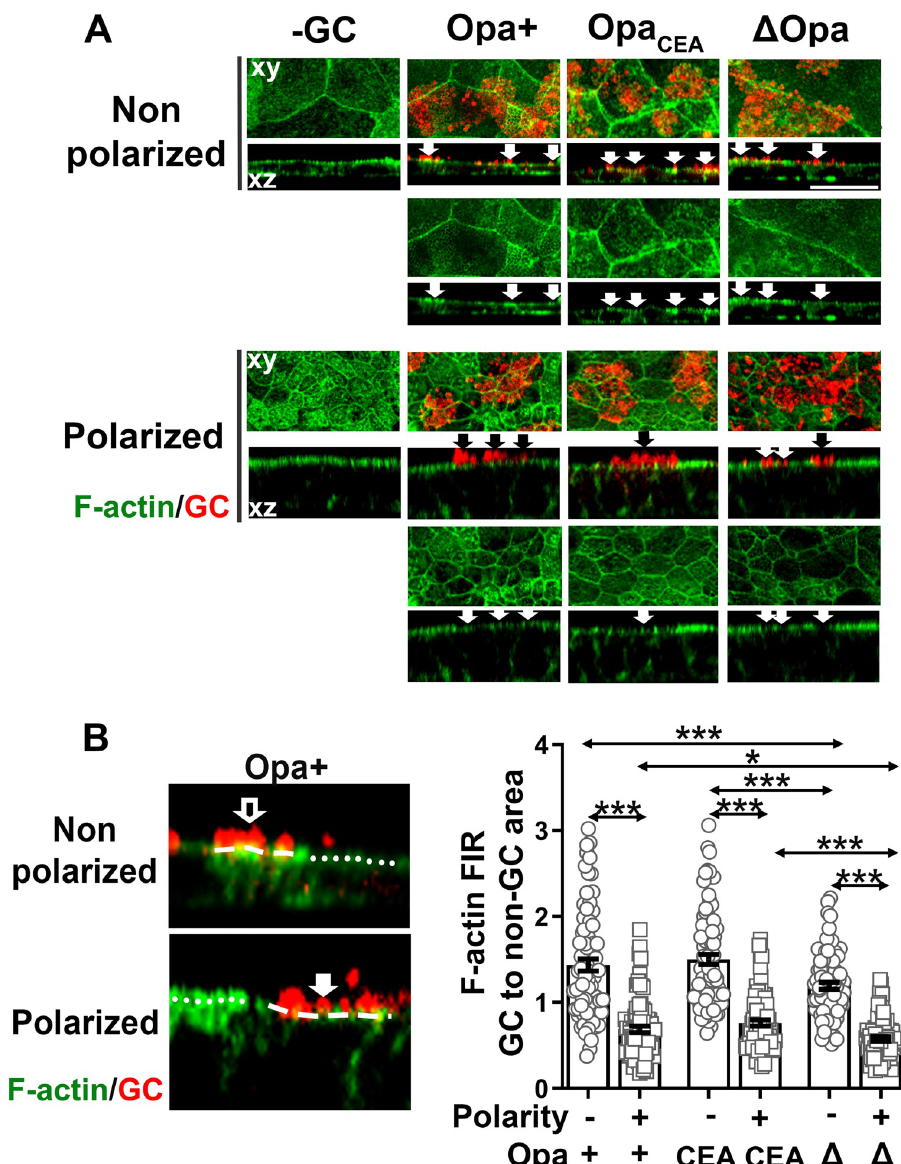
Fig 2. GC inoculation induces distinct F-actin reorganization in non-polarized and polarized epithelial cells. Non- polarized and polarized T84 cells were apically inoculated with Pil+Opa+, Opa CEA or Δ Opa GC (MOI~10) from the top chamber for 6 h. Cells were fixed, stained for F-actin and GC, and analyzed using 3D-CFM. (A) Representative xy images of the top surface and xz images crossing the top and the bottom surfaces are shown. Arrows indicate the location of GC. (B) The redistribution of F-actin was quantified by the mean fluorescence intensity ratio (FIR) ( ± SEM) of F-actin underneath individual GC microcolonies relative to the adjacent no GC surface area. Data points represent individual GC microcolonies. Scale bar, 20 μ m. n = 3 three independent experiments. � p < 0.05; �� p < 0.01; ��� p <